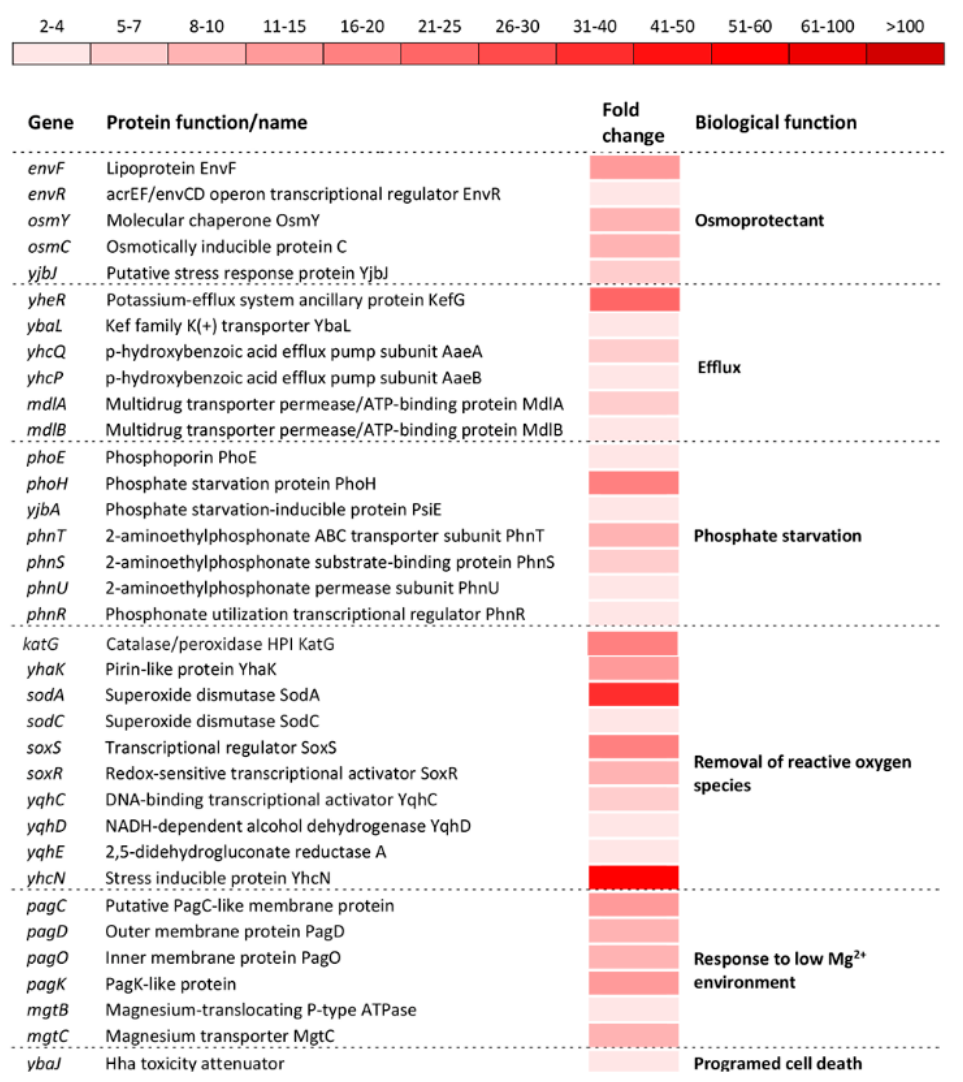
Figure 4. Differential expression of genes involved in cell redox homeostasis and various stress responses. The mean fold-increase in each gene expression after exposure to 3 mM of H 2 O 2 compared with controls is indicated by the color scale bar. Note that a variety of biological functions including multiple stress response, DNA repair, protein protection, refolding and digestion, osmoprotectants, efflux, phosphate starvation, removal of reactive oxygen species, response to low Mg 2+ environment and programed cell death belong to a more general biological function called “Stress response”.